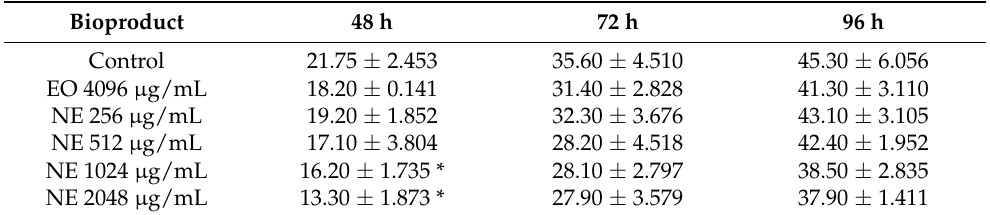
Table 6. Diameter (mm) of A. parasiticus colonies in the presence of the EO and the NE at 48, 72, and 96 h.